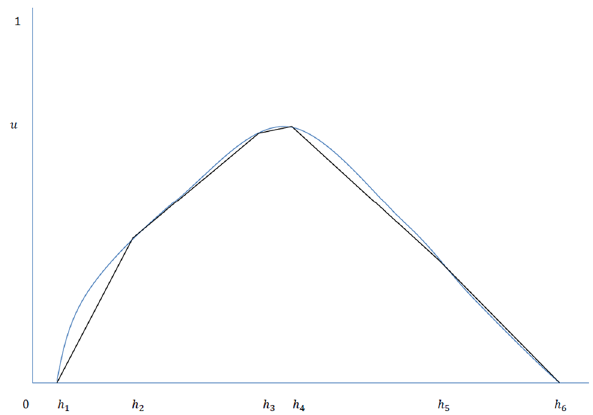
Fig. 5 Nonlinear fuzzy number approximated by GHXFN